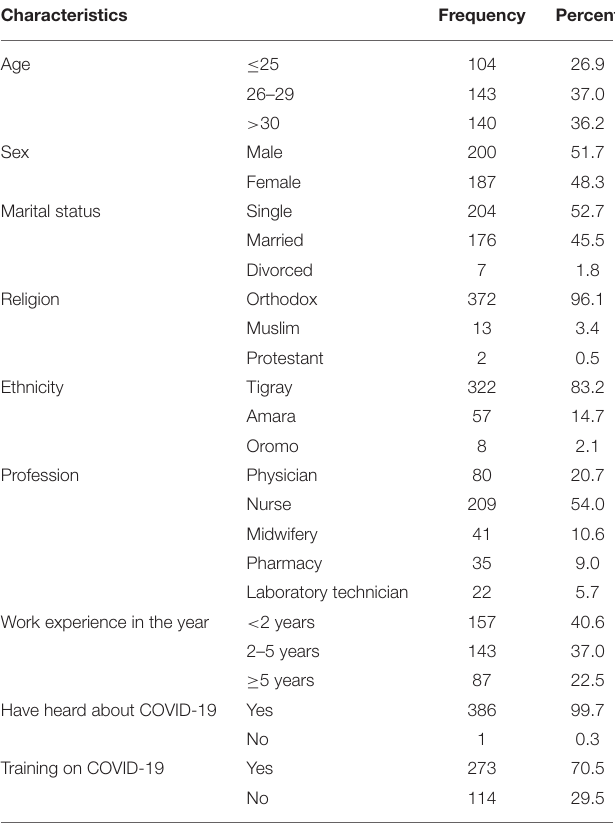
TABLE 1 | Sociodemographic characteristic of health workers at Aksum University Comprehensive and Specialized Hospital (AKUCSH) and Saint